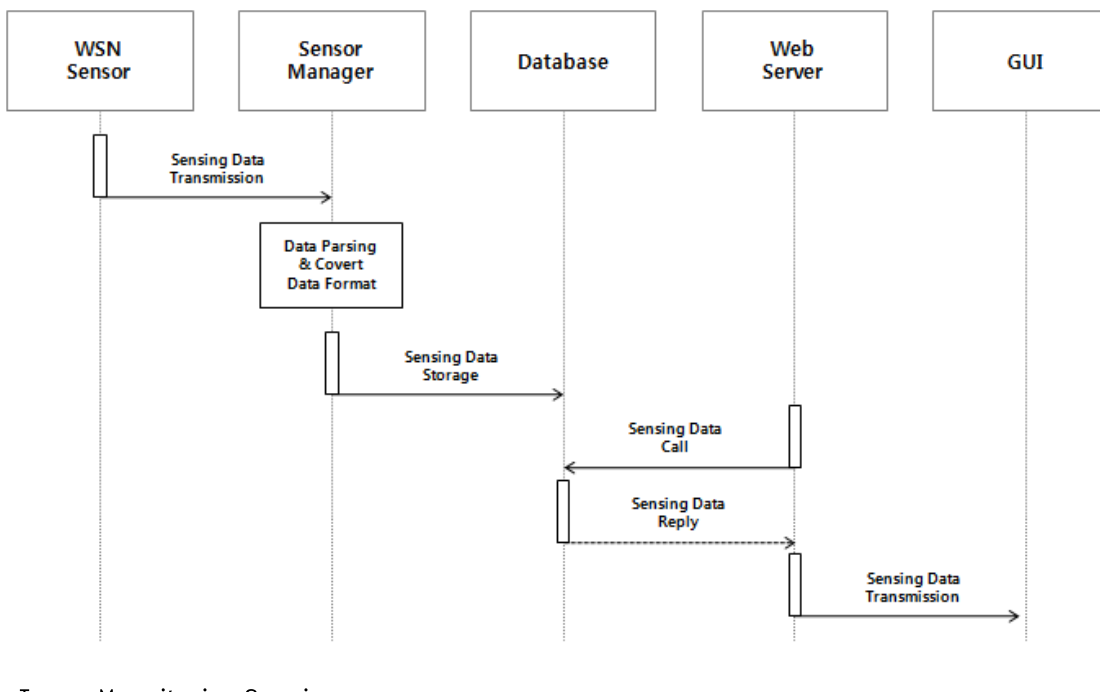
Figure 2. Operation Process of the Environment Monitoring